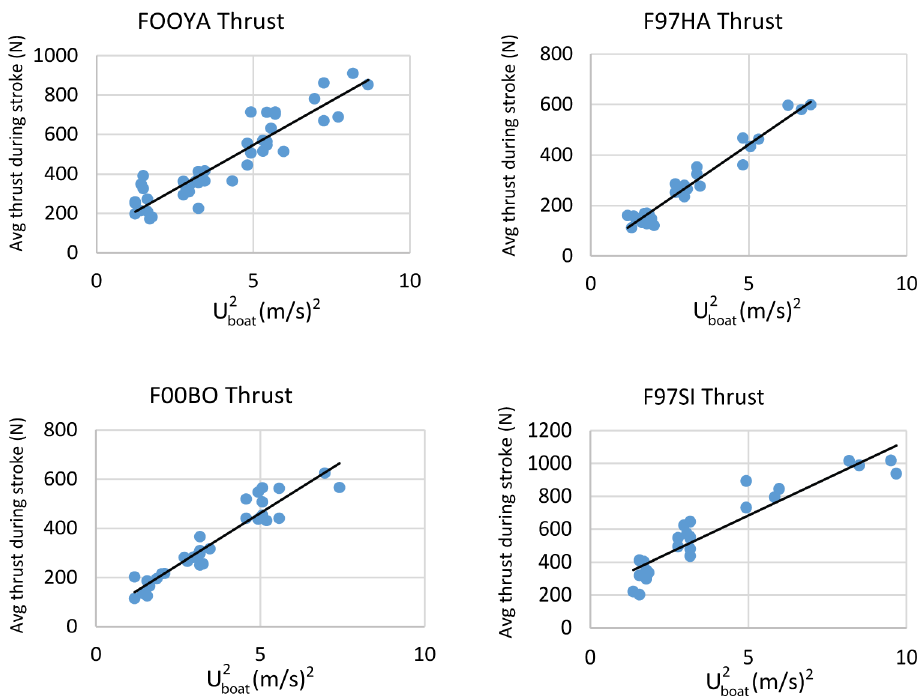
Fig 14. Average thrust during a stroke, as calculated via Eq 6, versus squared-boat speed.